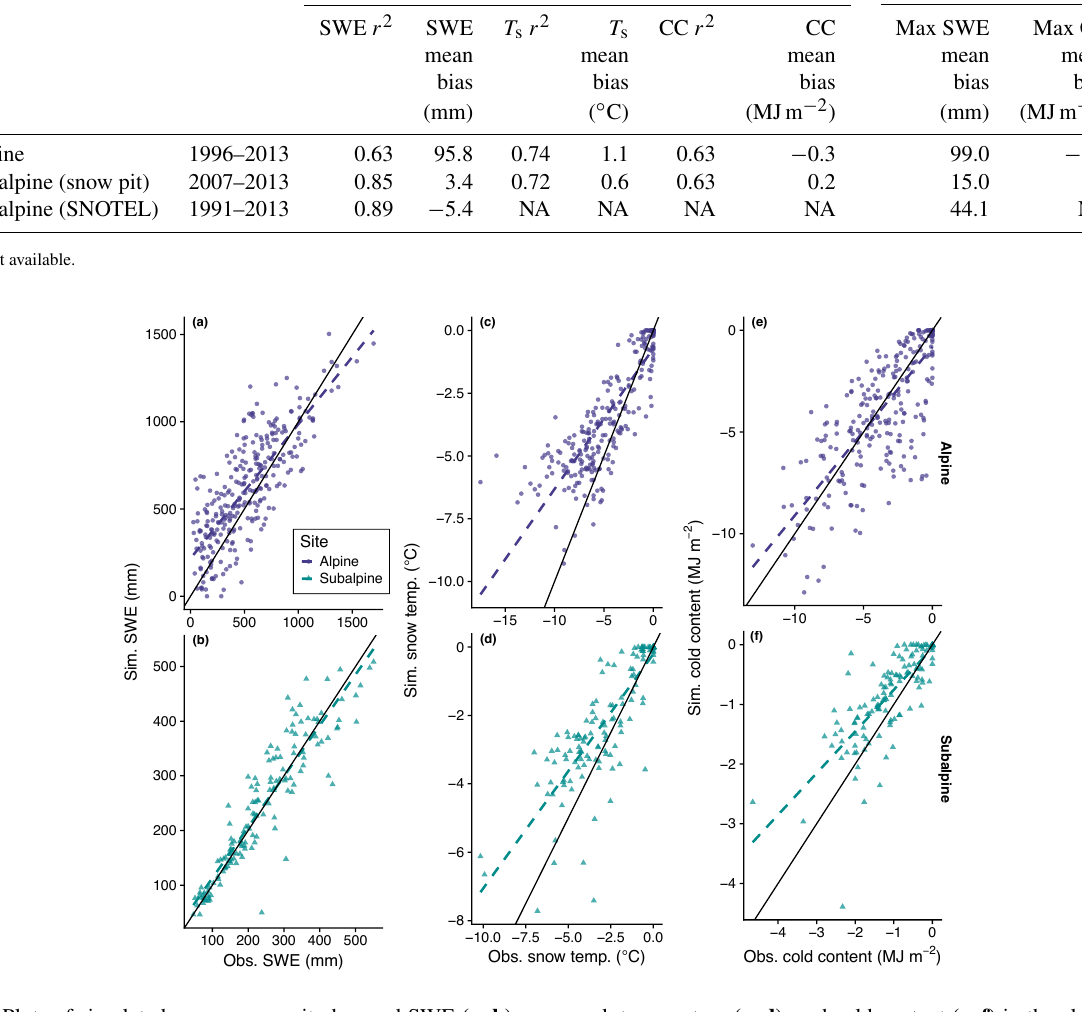
Figure 5. Plots of simulated versus snow-pit observed SWE (a, b) , snowpack temperature (c, d) , and cold content (e, f) in the alpine (top, WY1995–WY2013) and subalpine (bottom, WY2007–WY2013). The solid black line is the 1 : 1 line and the dashed lines are the lines of best fit as determined by ordinary least squares linear regression. Simulation error metrics are presented in Table